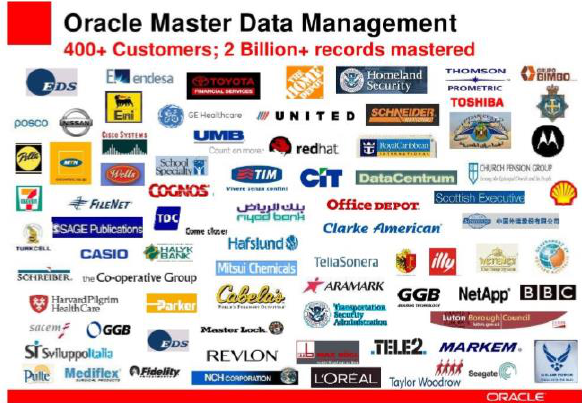
Fig. 3 . Big Organizations already used oracle